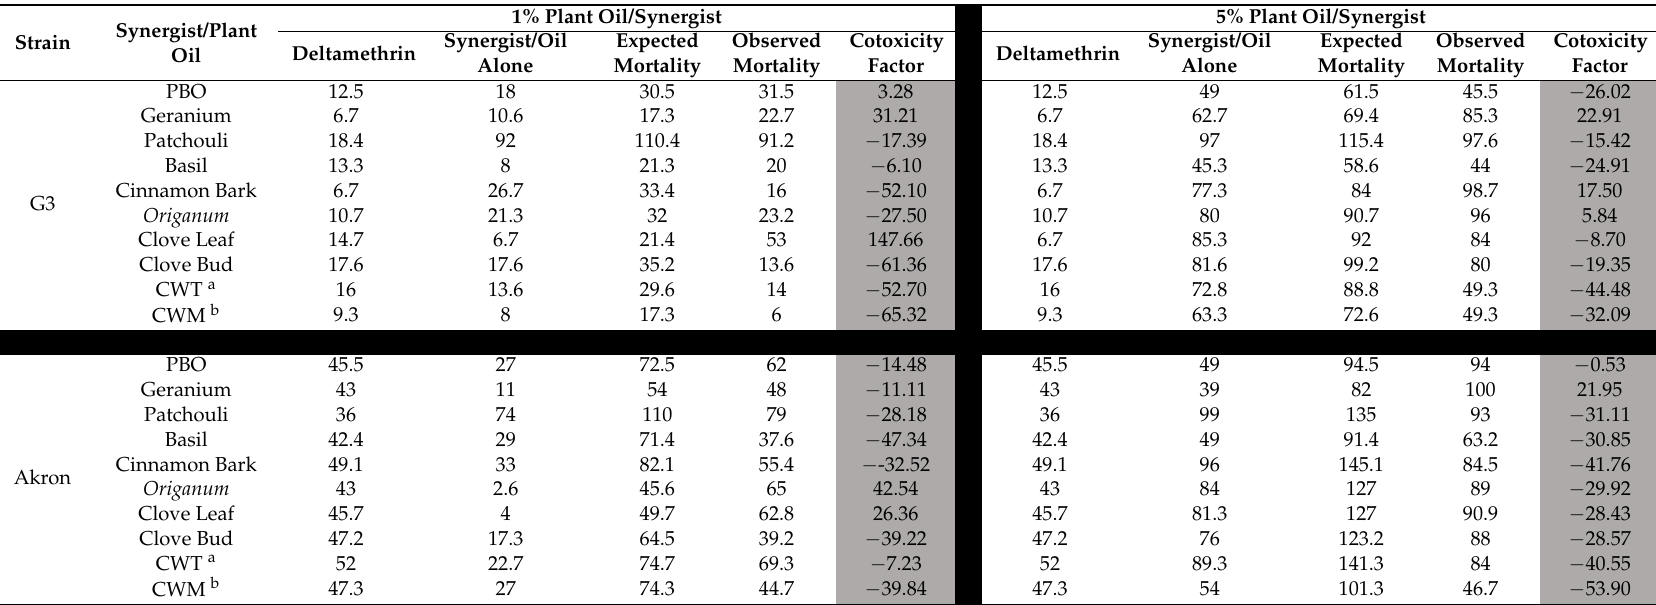
Table 5. Synergism caused by plant essential oils in combination with deltamethrin against An. gambiae